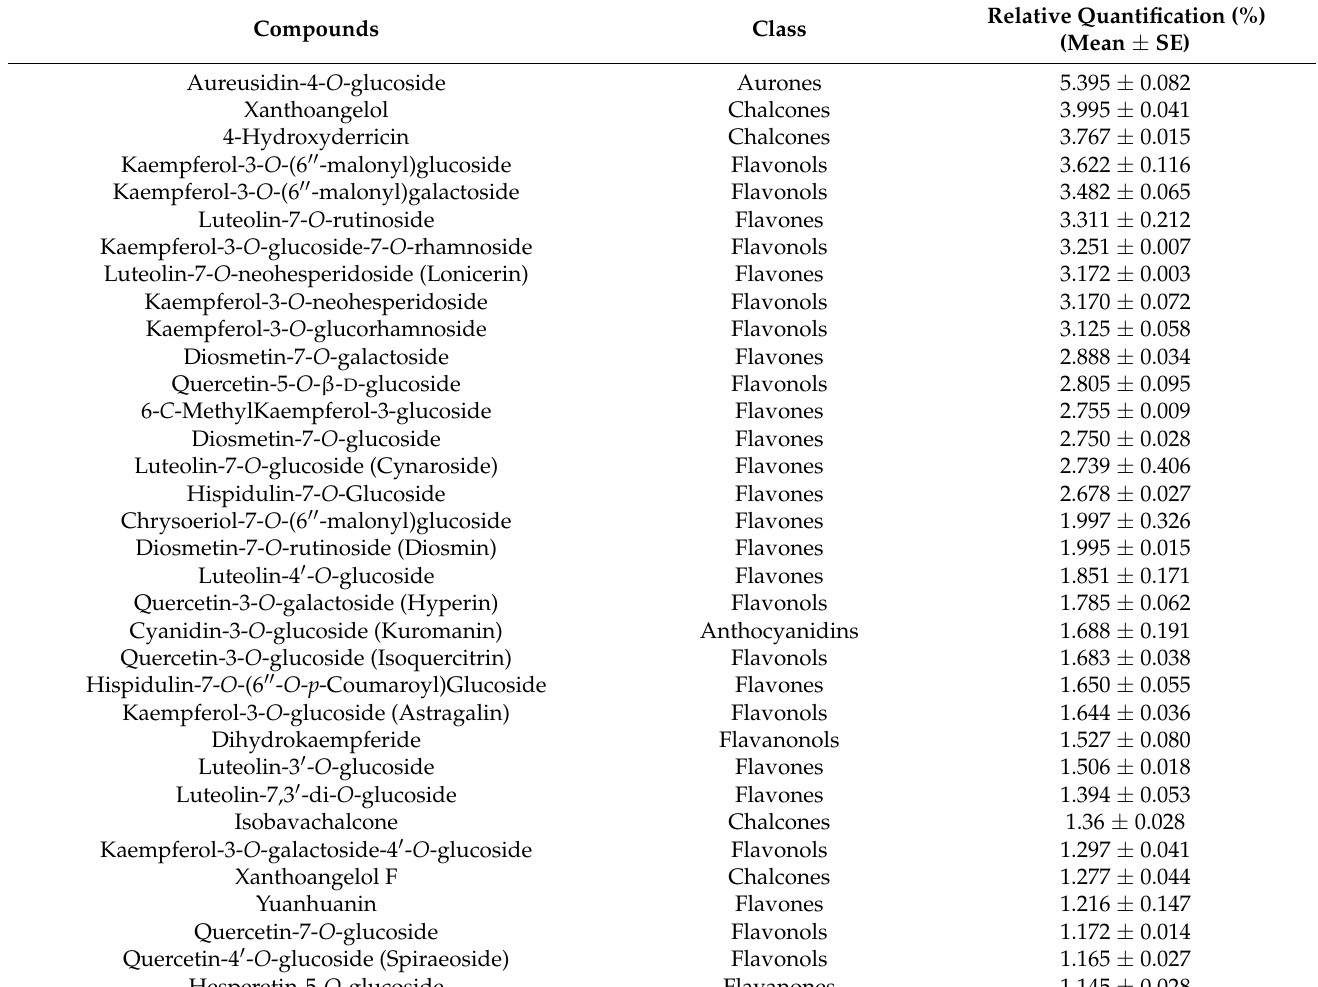
Table 1. Component analysis of flavonoids in the ethanol extract of Angelica keiskei